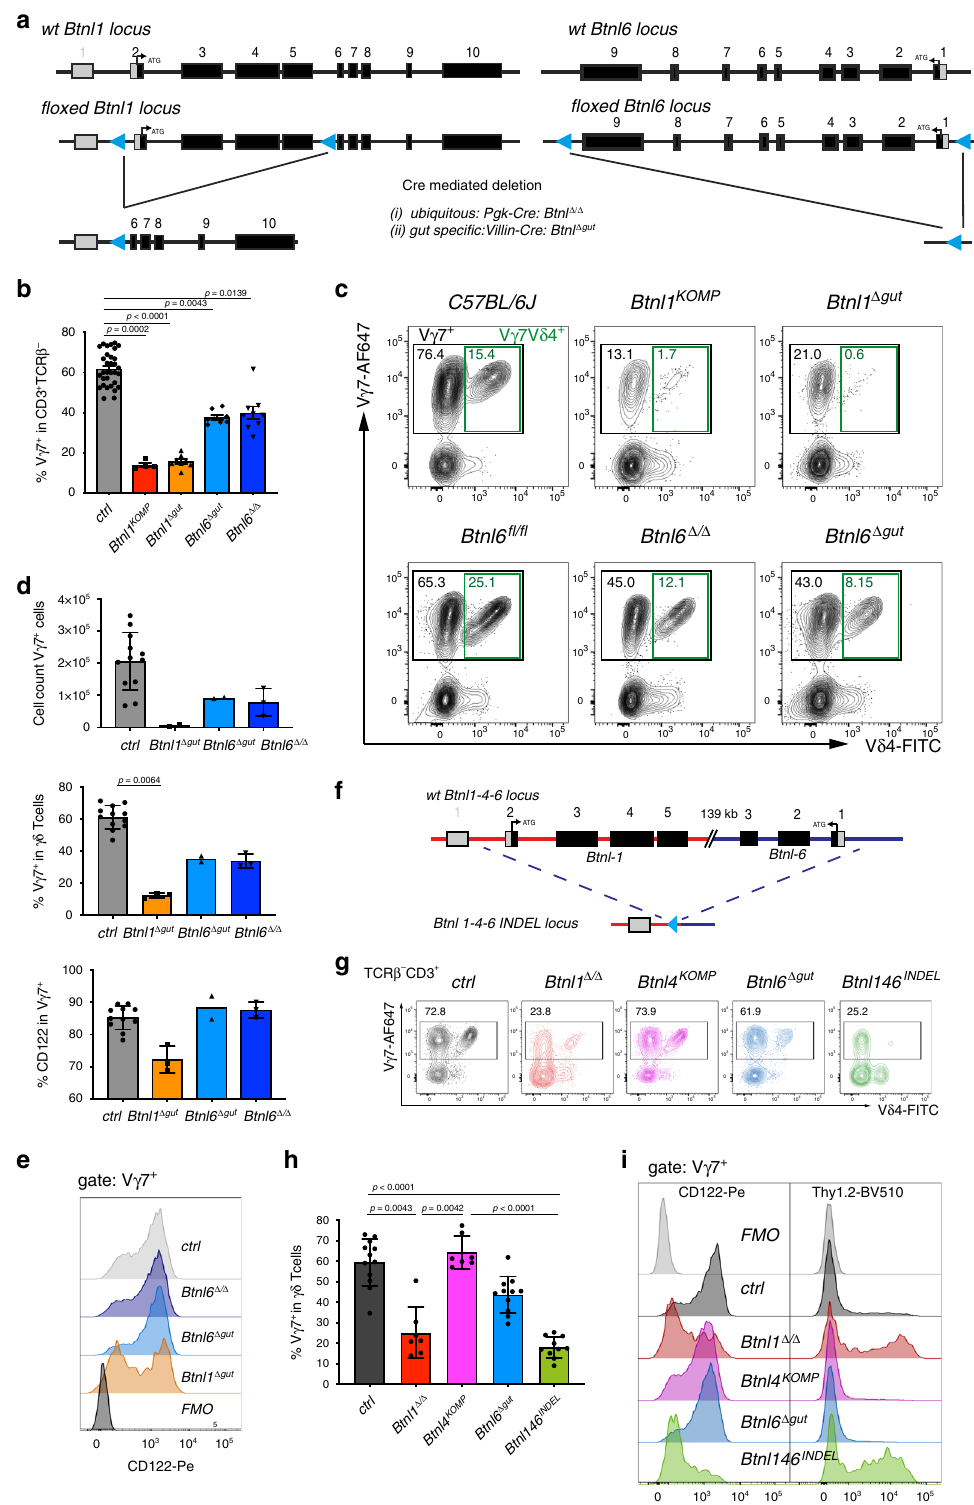
signi fi cant difference from controls (Fig. 3a – c, Supplementary Fig. 3). This unanticipated fi nding re fl ected the fact that V γ 7 + V δ 6.3 + IEL numbers were essentially unaltered in Btnl6 Δ